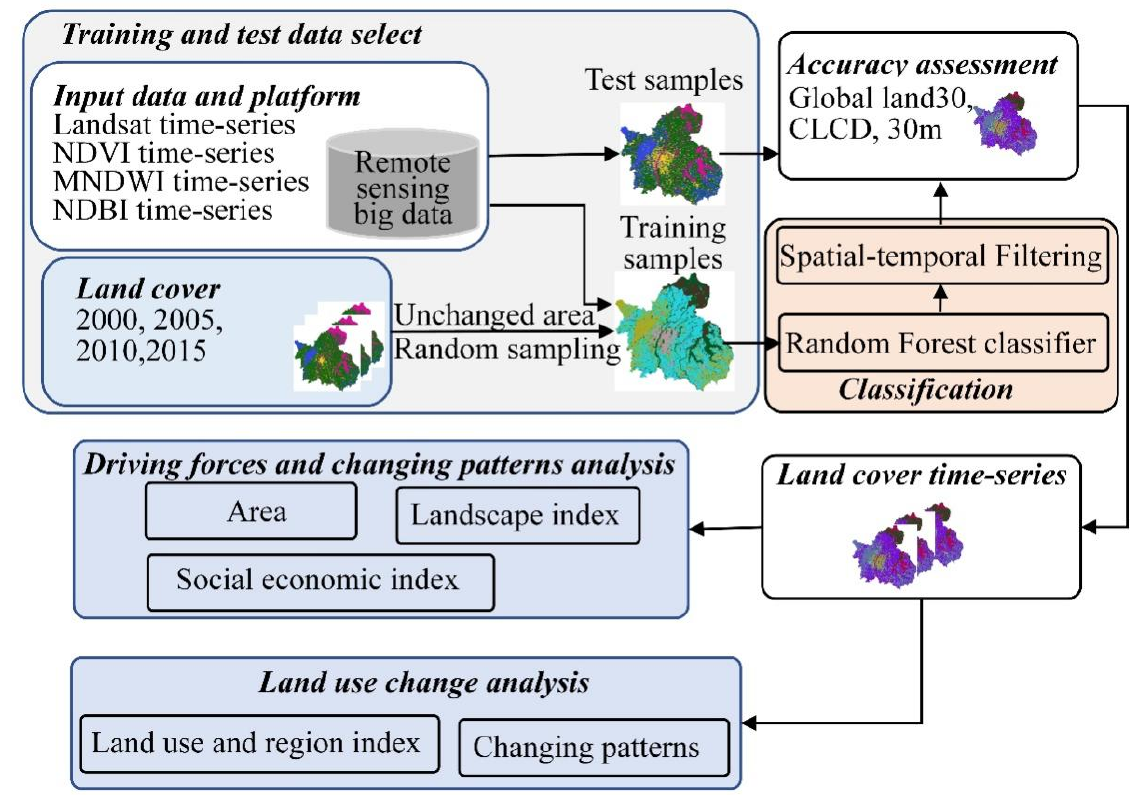
Figure 2. Research framework